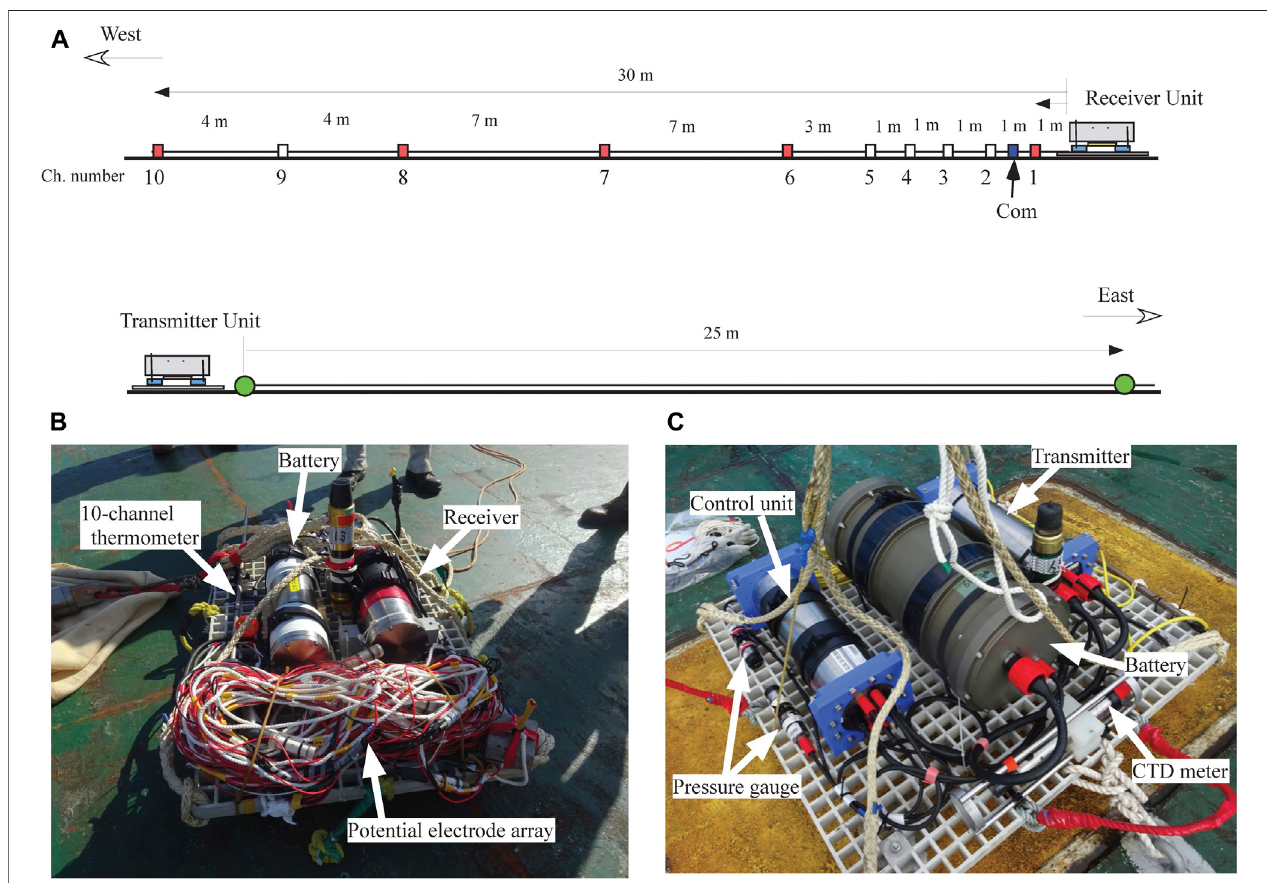
FIGURE 3 | (A) Electrode con fi guration of the receiver unit and the transmitter unit. Electrode cables have length of 30 m. (B) Photograph of the receiver unit. (C) Photograph of the transmitter unit.